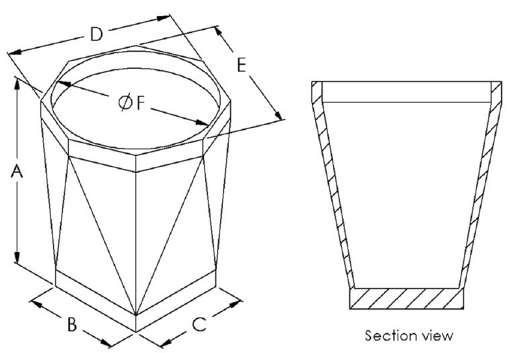
Figure 2. Evaluated dimensions on proposed geometry